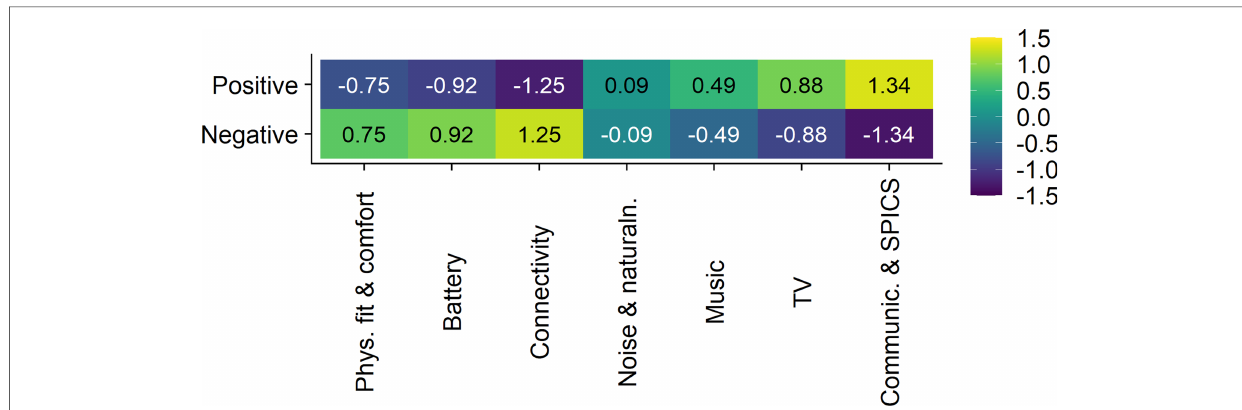
FIGURE 5 Heatmap visualizing the relationship between the seven clusters, i.e., the output of the cluster analysis ( x -axis), and the ratio of positive vs. negative self- reported satisfaction ratings ( y -axis). The values in the cells represent the standardized residuals of the two-sided χ 2 Test of Independence. Their signs inform about the direction of the outcomes, with positive values (represented by green to yellow background colors) indicating a positive relationship and negative values (represented by blue to purple background colors) indicating a negative relationship. The names of the seven clusters on the x -axis are abbreviated. Their full names are, from left to right, “ physical fi t and comfort ” , “ battery ” , “ connectivity ” , “ noise and naturalness of sounds ” , “ music experience and sound quality ” , “ TV experience and loudness comfort ” , “ communication and speech intelligibility in challenging situations ”